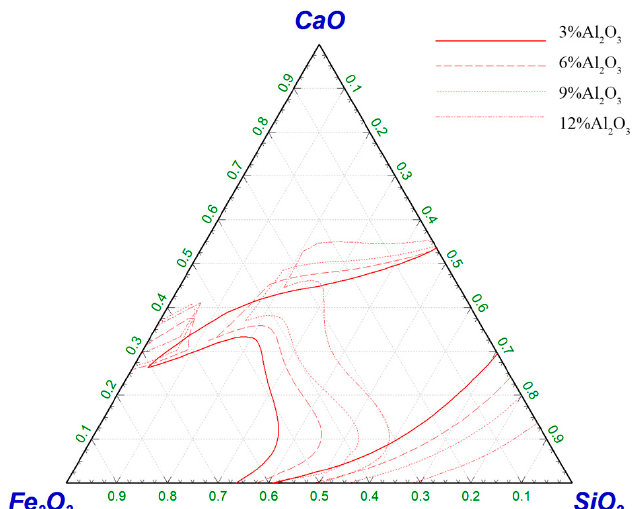
Figure 8. Effect of ω (Al 2 O 3 ) on the liquid-phase region of CaO–SiO 2 –Fe 2 O 3 –Al 2 O 3 –6%MgO slag system at 1450 °C.